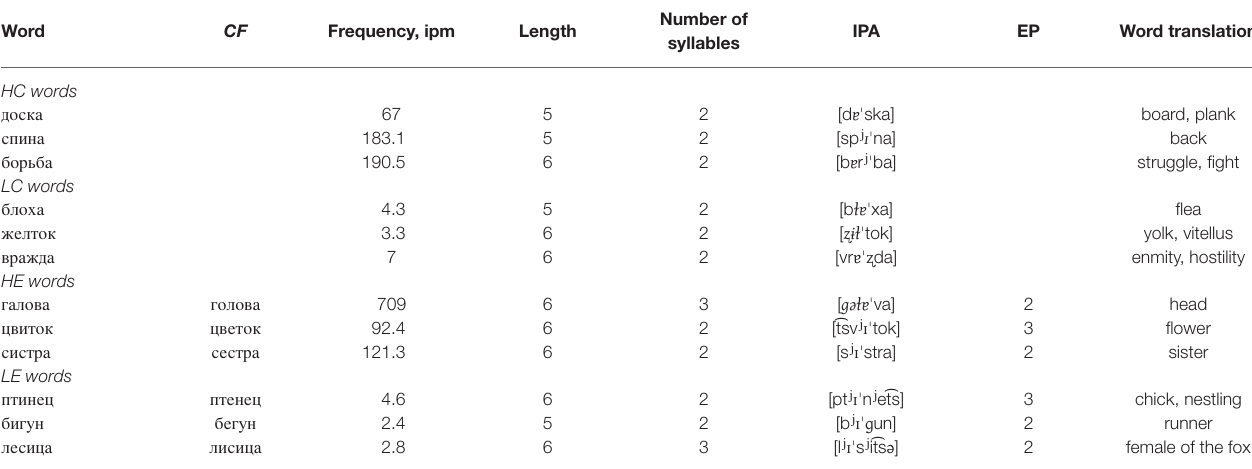
TABLE 1 | Examples stimuli for each condition in the behavioral